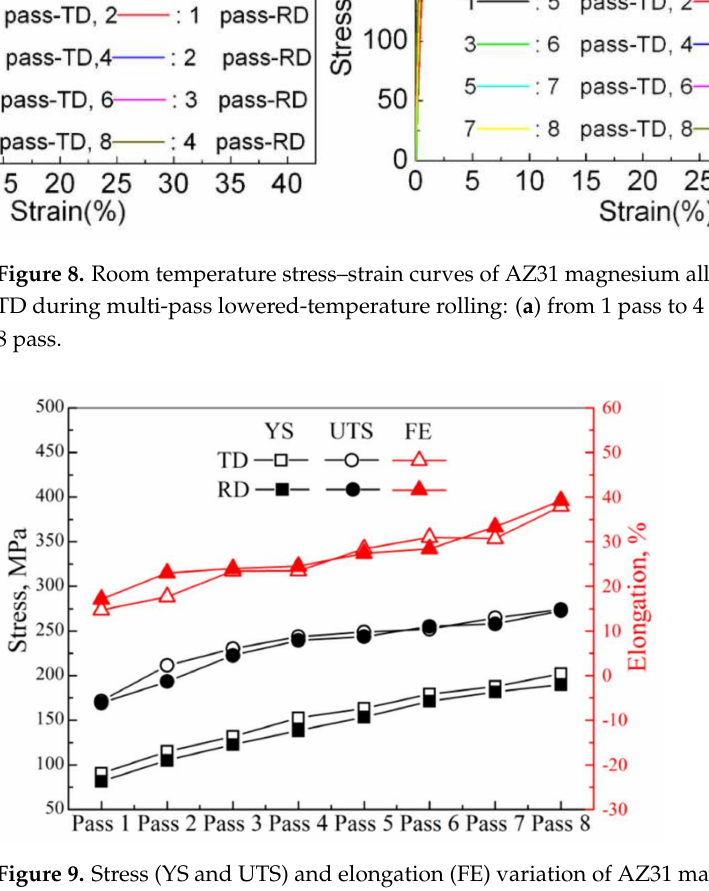
Figure 9. Stress (YS and UTS) and elongation (FE) variation of AZ31 magnesium alloy sheets along the RD and TD during multi-pass lowered-temperature rolling (YS: yield stress; UTS: ultimate tension stress; FE: fracture